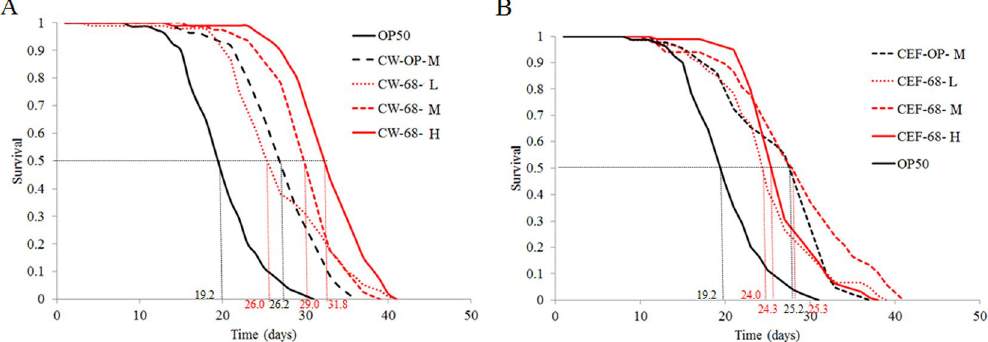
Figure 3. The cell wall is the main effective component of BB68 on nematode longevity. ( A ) Feeding worms the cell wall (CW) of BB68 (0.12 mg and 1.2 mg per plate) significantly increased the lifespan of nematodes relative to feeding them OP50 CW (0.12 mg per plate). ( B ) Feeding worms cell wall-free extracts (CFE) of BB68 did not affect the lifespan of nematodes relative to the lifespan of nematodes fed OP50